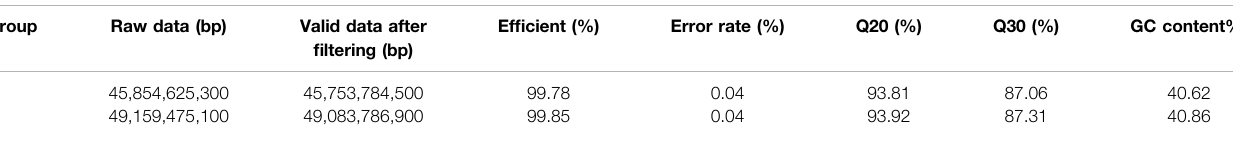
TABLE 2 | Summary of sequencing data quality. Group Raw data